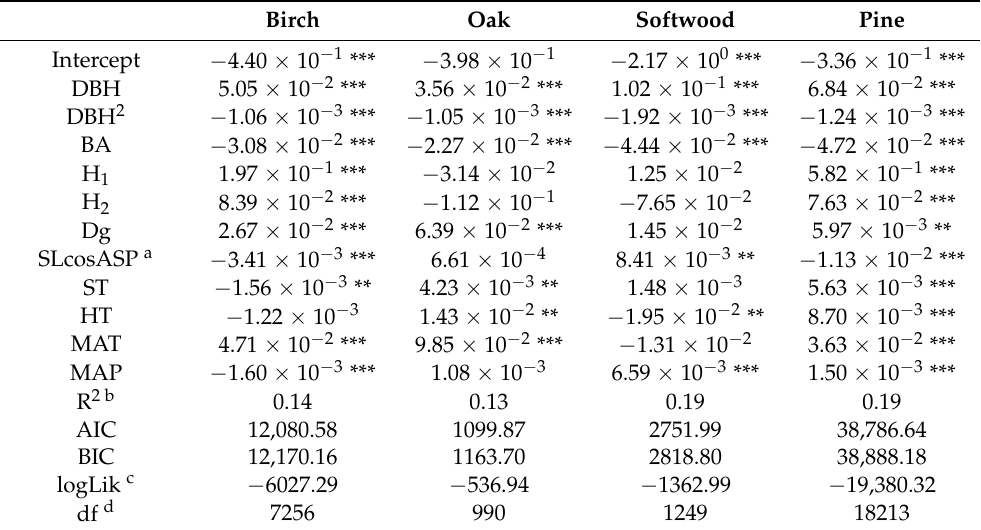
Table 4. The estimated parameters with the lack-of-fit statistics for the tree diameter increment model. The dependent variable, diameter increment, was measured in centimeter every five years. Birch Oak Softwood